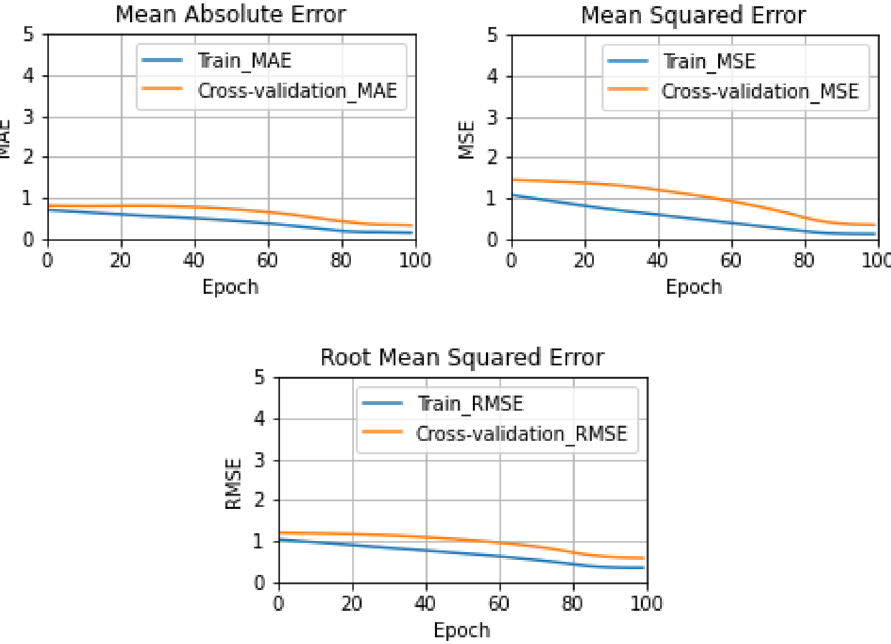
Figure 4. Performance evaluation on attention-assisted 1D CNN-BiLSTM model: MAE, MSE, and RMSE.